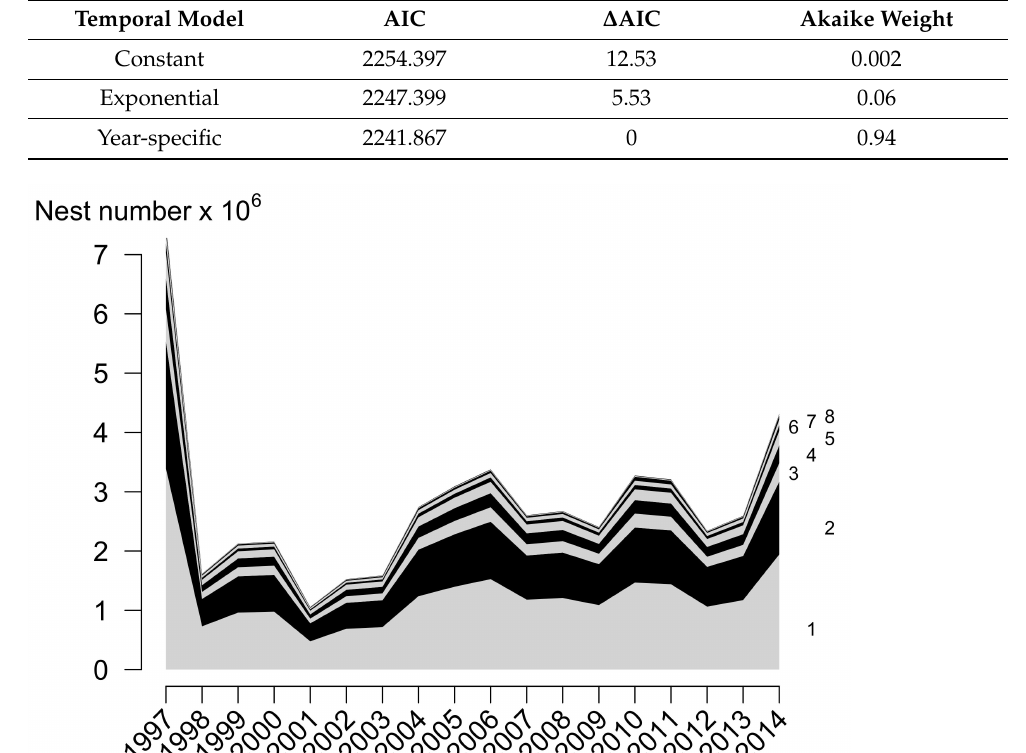
Table 1. Model selection for temporal distribution of olive ridley nesting activity in Central America.